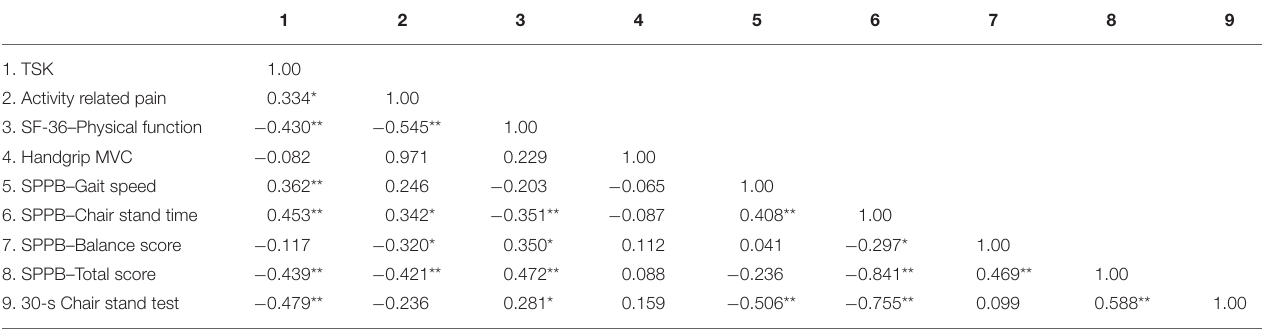
TABLE 2 | Bivariate correlation matrix between Tampa Scale of Kinesiophophia (TSK), activity-related pain, and the physical function measures.